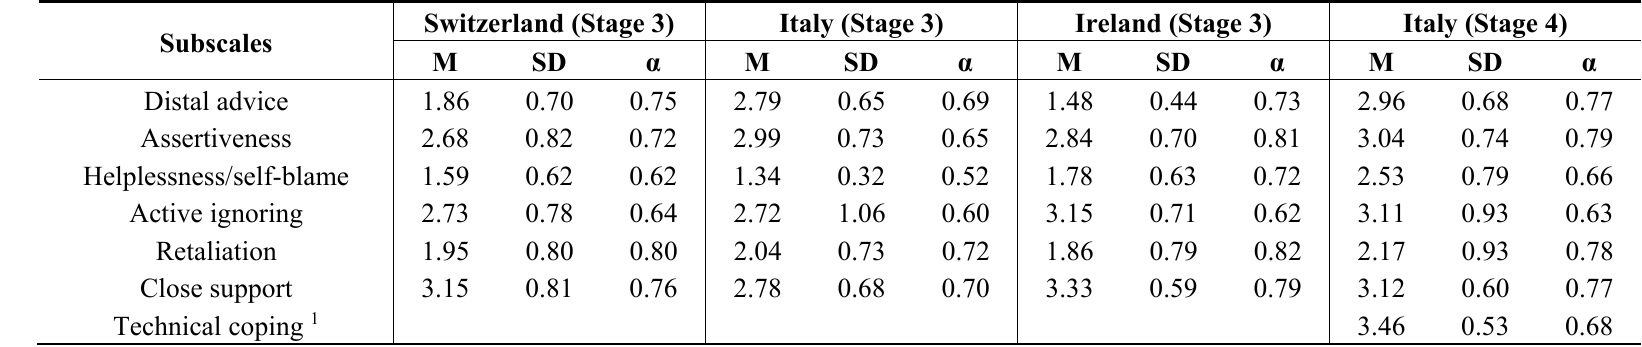
Table 3. Descriptive statistics and reliabilities (Cronbach’s alpha) of the subscales of the Coping with Cyberbullying Questionnaire (CWCBQ) at Stage 3 ( N = 3970) and Stage 4 ( N =